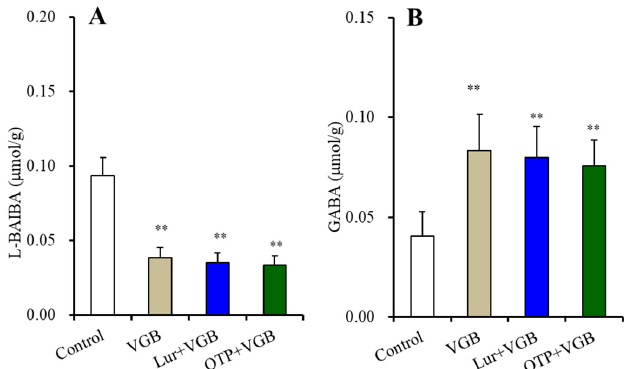
Figure 8. Interaction among chronic exposures of lurasidone (Lur: 500 nM for 14 d), quetiapine (QTP: 30 µ M for 14 d), and vigabatrin (VGB: 200 µ M) on intracellular levels of L-BAIBA ( A ) and GABA ( B ) in the astrocytes. Astrocytes were exposed to 200 µ M vigabatrin alone (VGB), 200 µ M vigabatrin with 500 nM lurasidone (Lur + VGB), 200 µ M vigabatrin with 30 µ M quetiapine (QTP + VGB) or vehicle alone (control: fDMEM containing 0.1% DMSO) for 14 d. Ordinate indicates mean ± SD ( n = 6) of levels of L-BAIBA and GABA in the astrocytes ( µ mol/g protein). **: p < 0.01: relative to control by ANOVA with Tukey’s post hoc